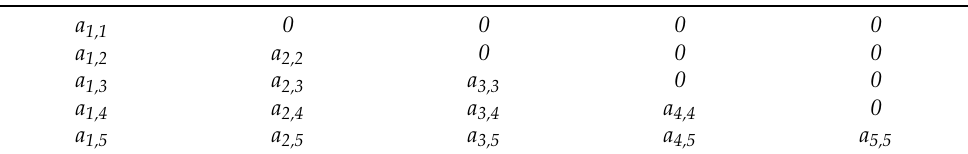
Table 1. The appearance matrix for a PSD with 5 different size bins. Each column for progeny Equation